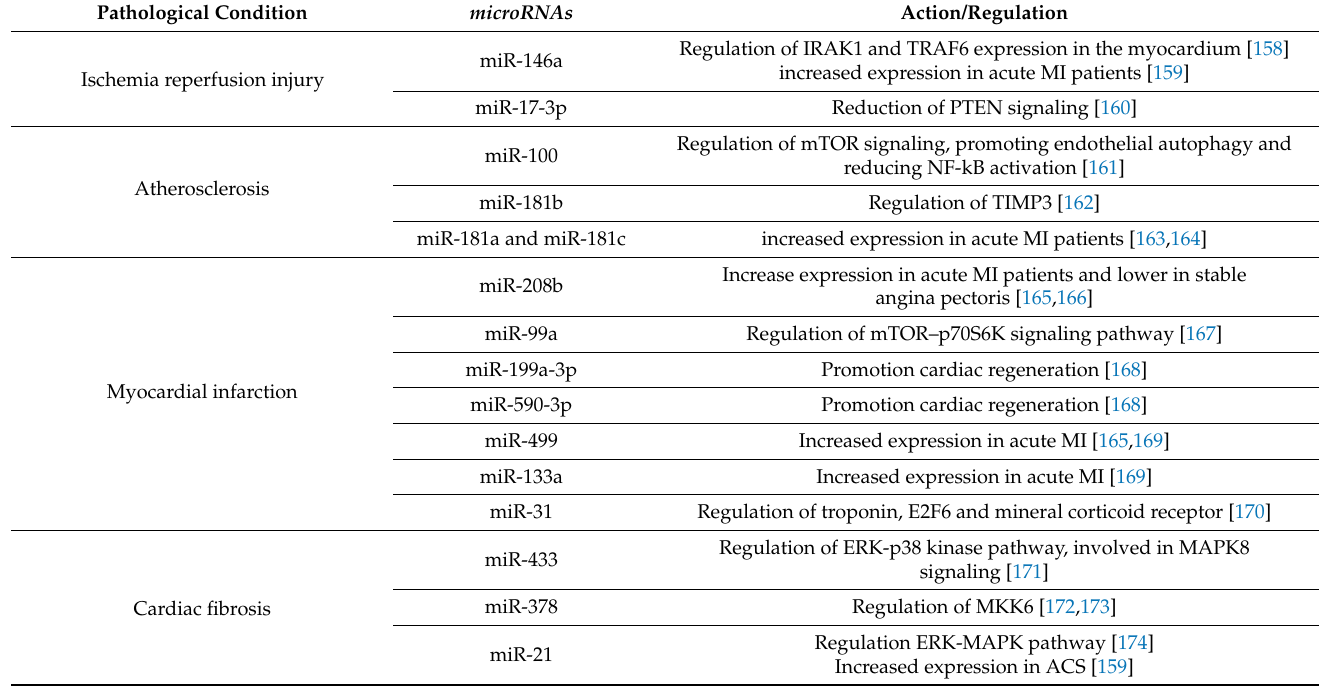
Table 2. Main non-coding RNAs and cardiovascular conditions related to acute coronary